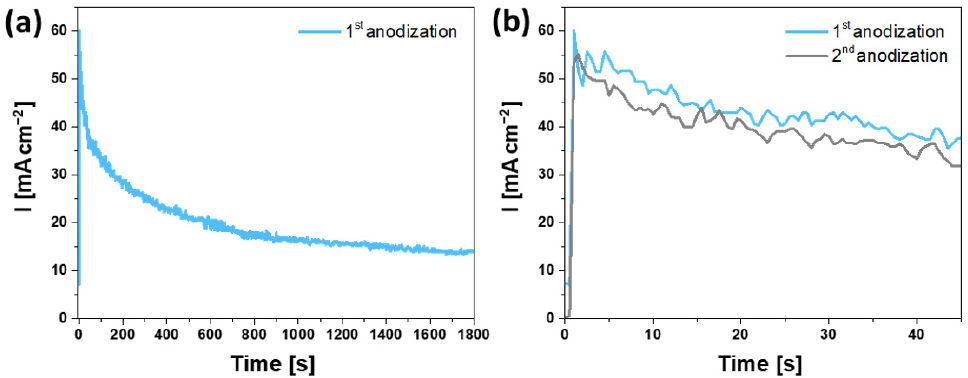
Figure 1. Current density vs. time curves recorded during 30 min of 1st anodization step ( a ) and 45 s of 1st and 2nd anodization steps ( b ). Anodizations of Zr foil were carried out at 12 V in the electrolyte composed of 1 M (NH 4 ) 2 SO 4 and 0.08 M NH 4